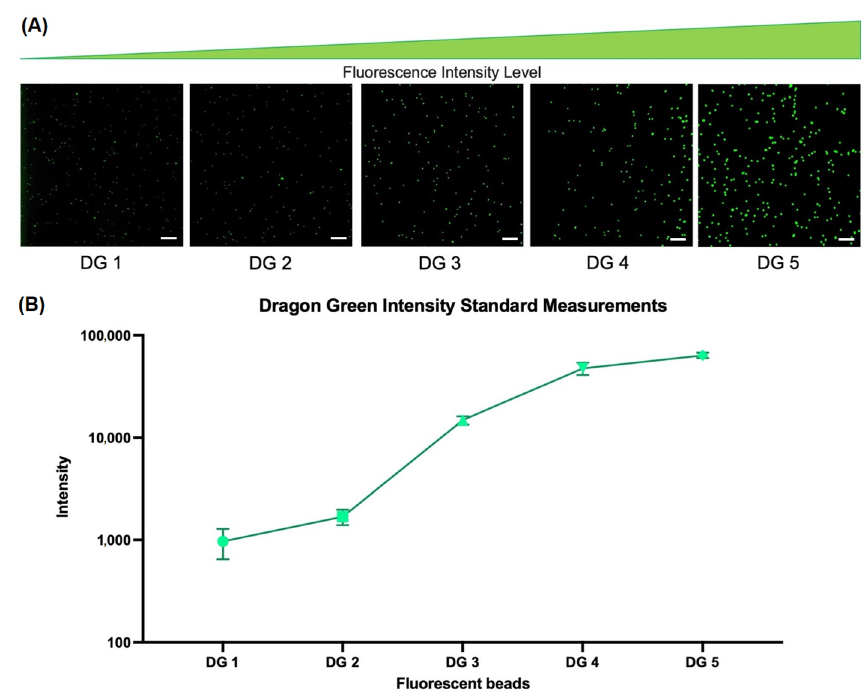
Figure 3. Quantifying sensitivity of the Tissue Imager. Quantifying sensitivity of the Tissue Imager. ( A ) Image of the Dragon Green (DG) intensity standard beads of ~8 µm diameter polystyrene-based microspheres dyed with increasing amounts of the DG fluorophore to quantify the sensitivity of the Tissue Imager. ( B ) Average intensity values of each bead population are plotted. The scatter plot shows the average values with standard deviations. Scale bars, 100 µm.